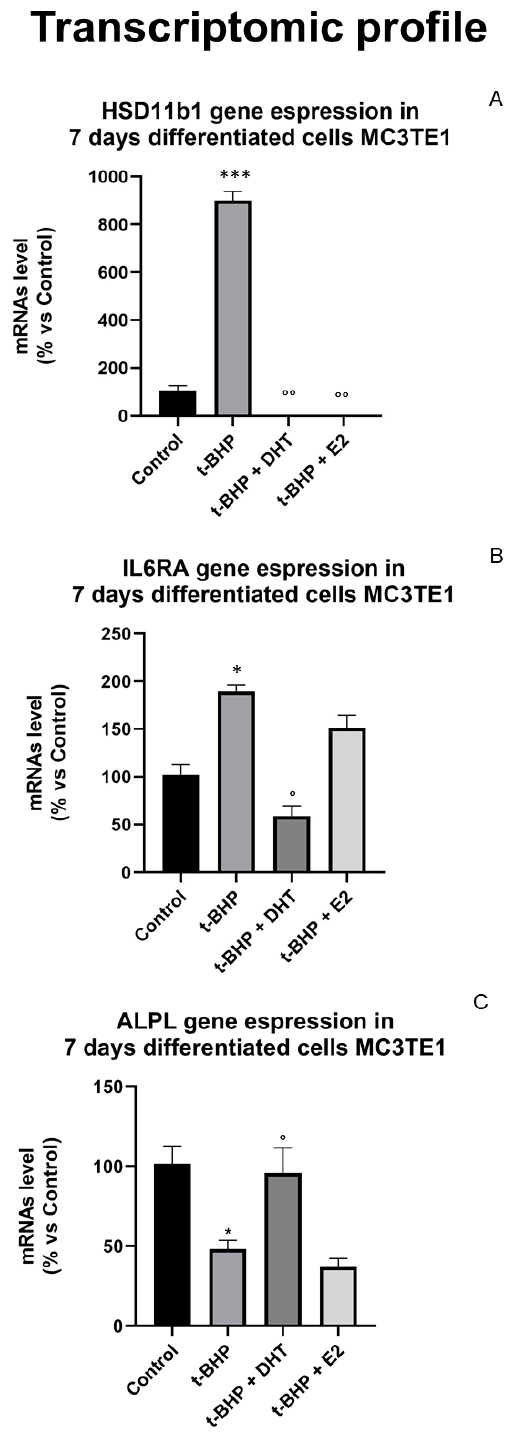
Figure 5. Effects of steroids on transcriptomic profile of genes related to osteoporosis pathway. Effects of steroids (10 − 8 M, 24 h before t-BHP) in differentiated MC3T3-E1 cells exposed to t-BHP (125 µ M, 3 h) on gene expression of HSD11b1 ( A ), IL6RA ( B ), ALP ( C ). The figure shows the effects of steroids in counteracting the gene expression disruption induced by t-BHP exposure. Data are represented as the mean ± SEM of six replicates within a single experiment. Differences between groups were evaluated by one-way ANOVA, followed by Bonferroni post-hoc test *** p < 0.001; * p < 0.05 vs. control. ◦ p < 0.05, ◦◦ p < 0.01; vs.